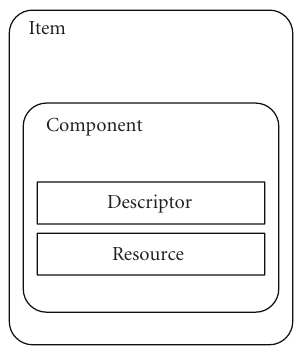
Figure 1: A schematic structure of an MPEG-21 digital item.